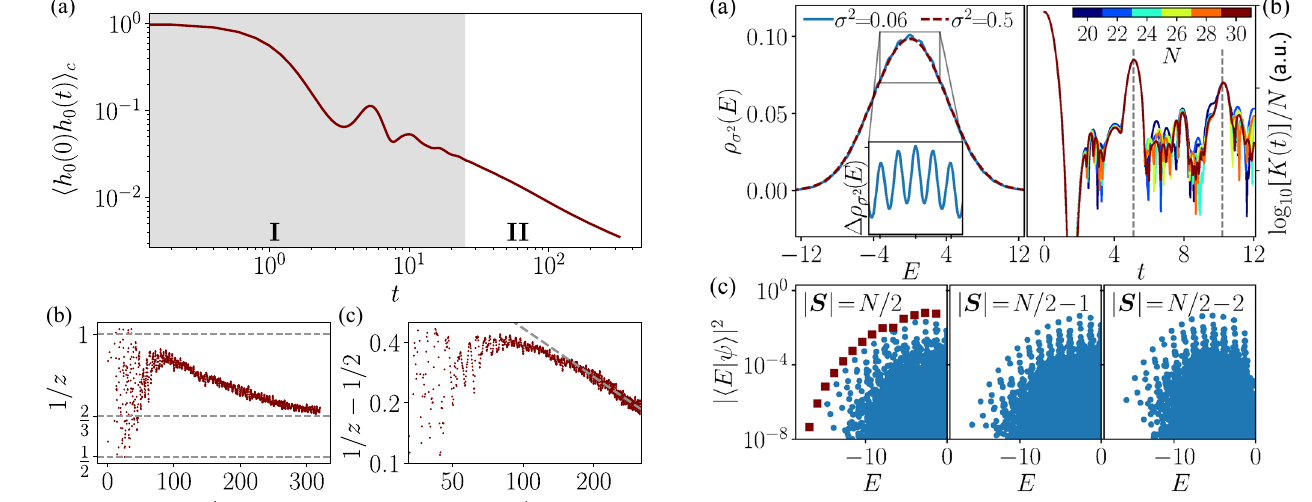
FIG. 2. Signatures of multiple su(2) representations in the PXP model. (a) Oscillations in the smoothened density of states for N ¼ 28 sites, with the inset showing the difference between different SDOSs (see text). (b) Spectral form factor for various system sizes. The dashed lines indicate the approximate times of the peaks in Fig 1. (c) Overlap between eigenstates of the global spin- 1 S z operator and the PXP eigenstates. The red squares denote the primary QMBS eigenstates with high overlap on the N´eel state. All data are obtained by exact diagonalization of the PXP model with periodic boundary